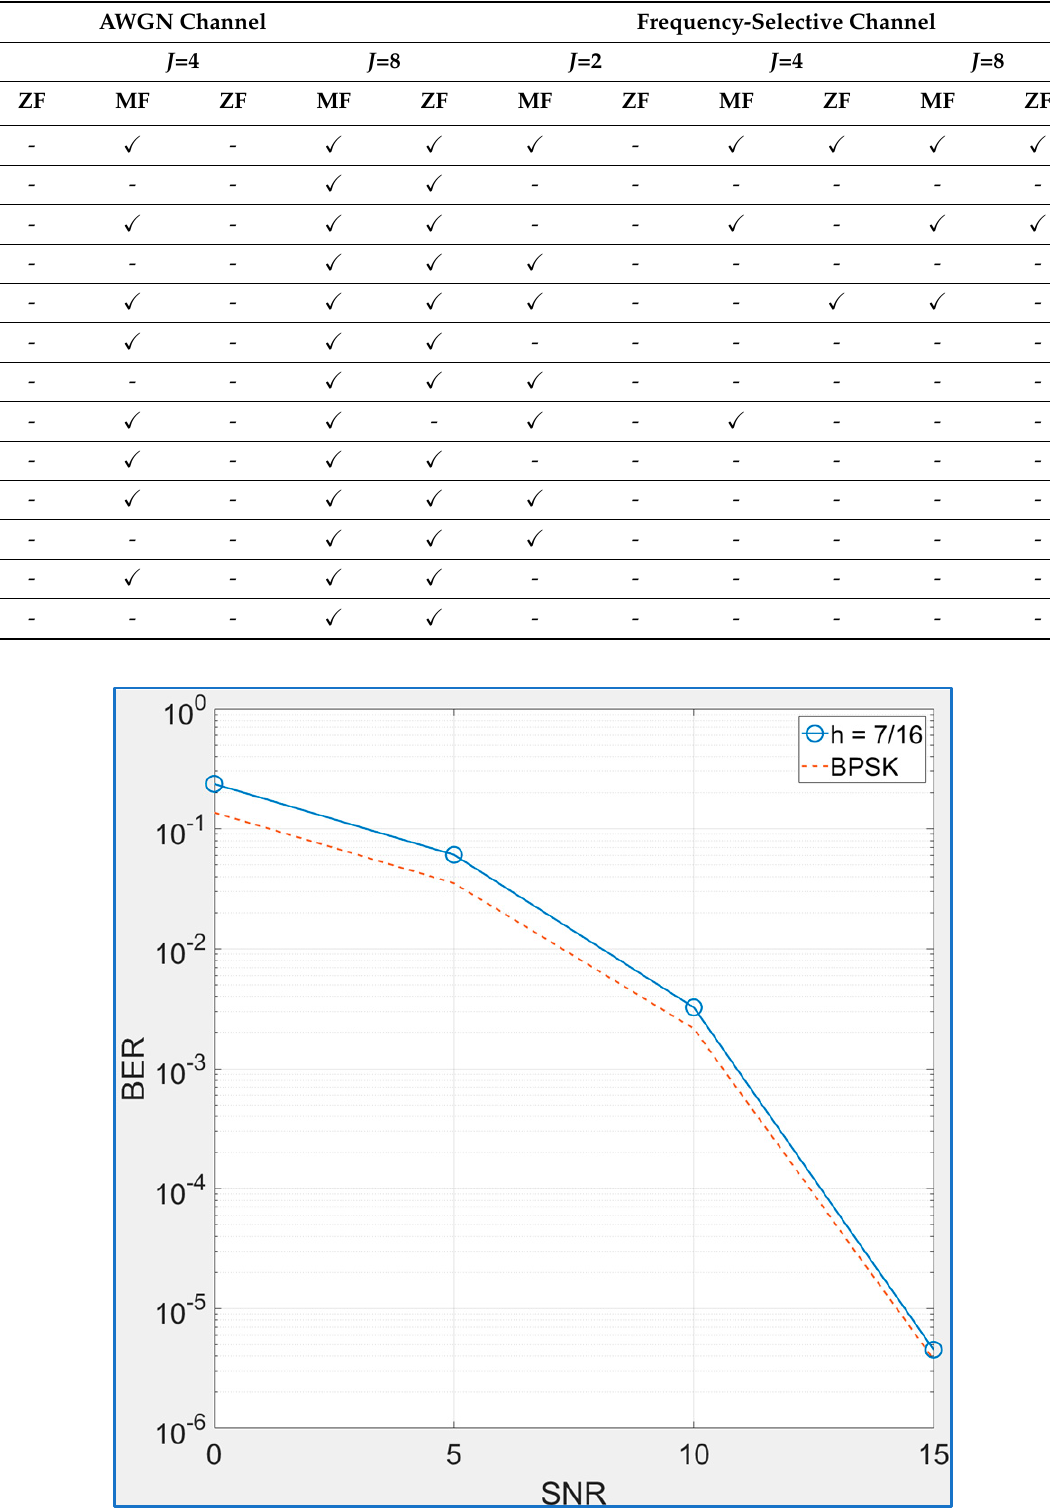
Figure 13. BER performance of binary CPM-GFDM vs. BPSK-GFDM for zero forcing receiver over frequency-selective channels . Table 4. Modulation Indices Giving Better Performance Than Conventional GFDM (Red color indi-